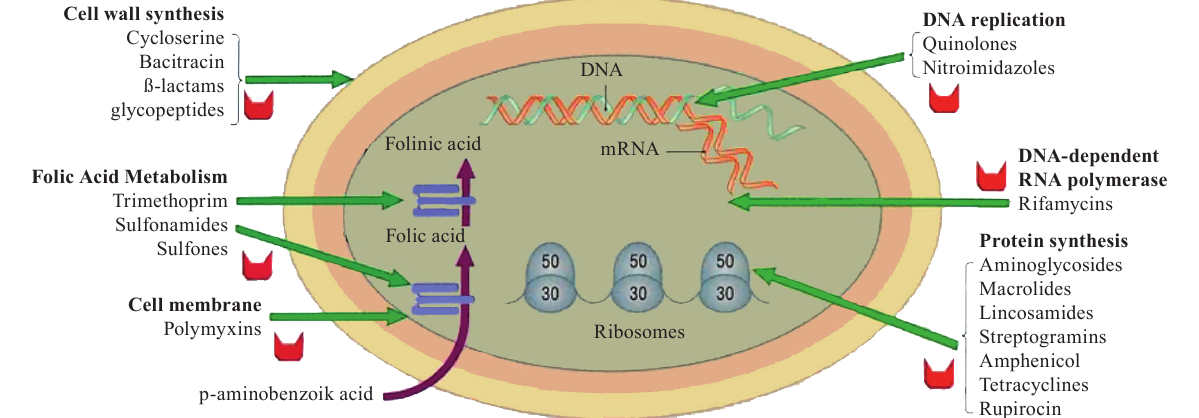
Cell wall synthesis